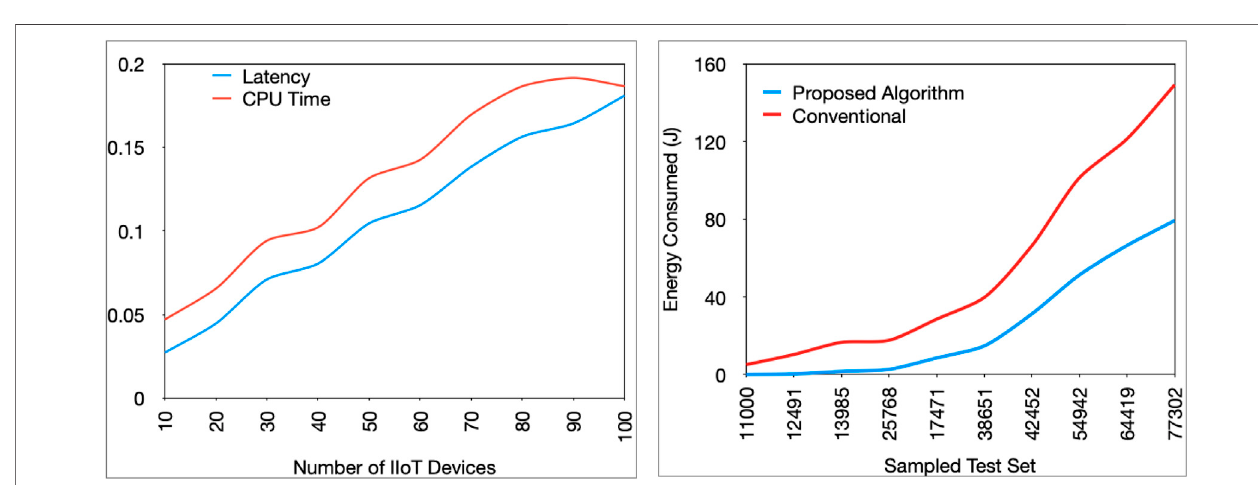
FIGURE 7 | Latency and energy